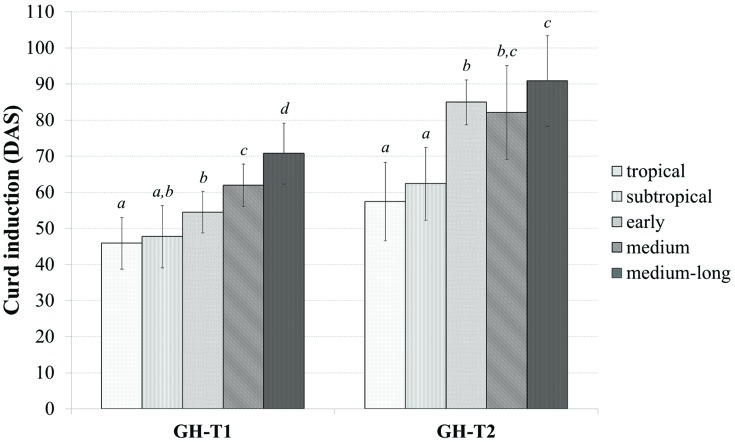
Phenotypic variation of curd induction (measured in DAS) among the cauliflower diversity set according to the classification into distinct groups consisting of early, medium, medium-long, subtropical and tropical accessions under a natural temperature regime (GH-T1) and high ambient temperatures of 22.5°C (GH-T2; mean ± SD, P < 0.05, Kruskal–Wallis test; similar letters indicate no significant statistical differences).